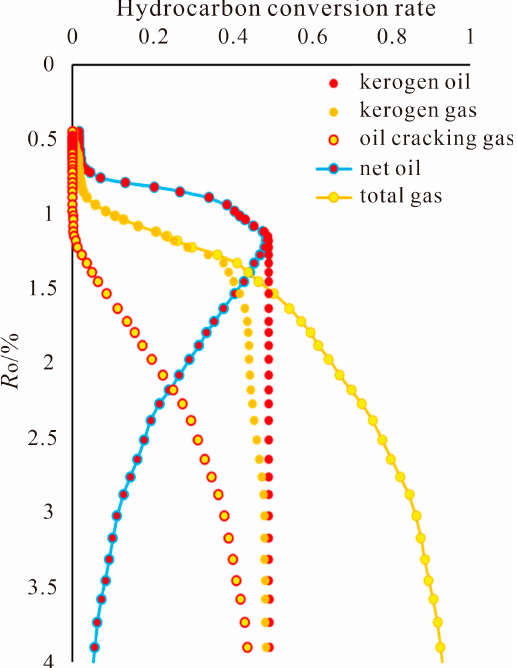
Figure 4. Hydrocarbon conversion rate pro fi le of organic ma tt er into hydrocarbons of immature type II 2 organic ma tt er [9]. II 2 organic matter